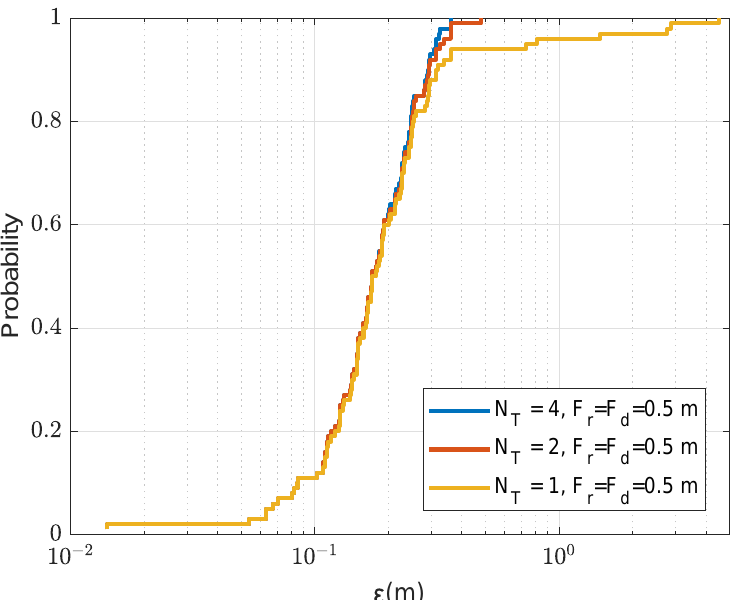
Figure 13. CDF for the localization error ε in the acoustic environment with the uniform SSP against the number of transmit antennas N T ; F r = F d = 0.5 m, the number of refinement areas is N max = 4, where only one point is removed after finding the next maximum and the refinement area is 2 m × 2 m as shown in Figure 5a.